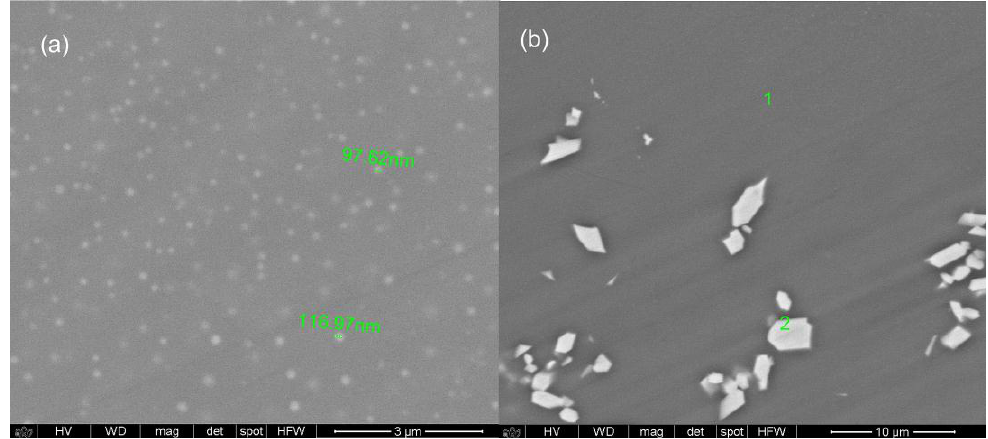
Figure 5. SEM image of SGS3P ( a ) and SGS5P ( b ) samples with approx. size of crystalline particles.